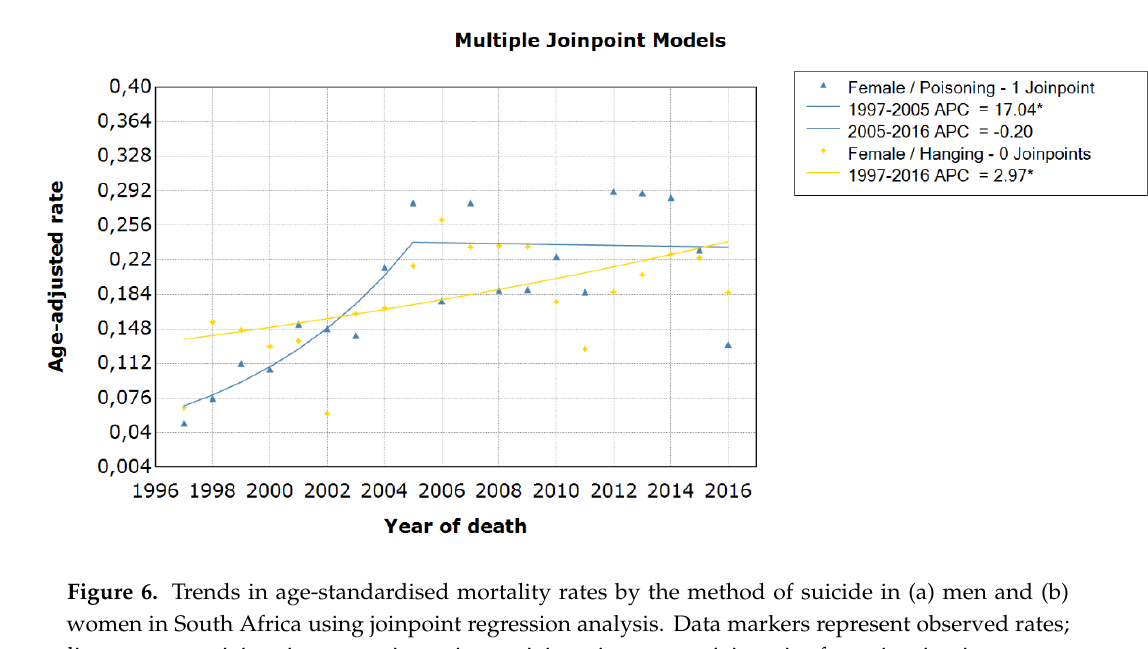
Figure 6. Trends in age-standardised mortality rates by the method of suicide in (a) men and (b) women in South Africa using joinpoint regression analysis. Data markers represent observed rates; lines represent joinpoint regression using no join points or one join point for poisoning in women. Joinpoint regression analysis for firearm use in women could not process records with dependent variable = 0; APC = annual percentage change; * indicates that the APC is significantly di ff erent from zero at the alpha = 0.05 level. ( a ) Men; ( b ) Women.